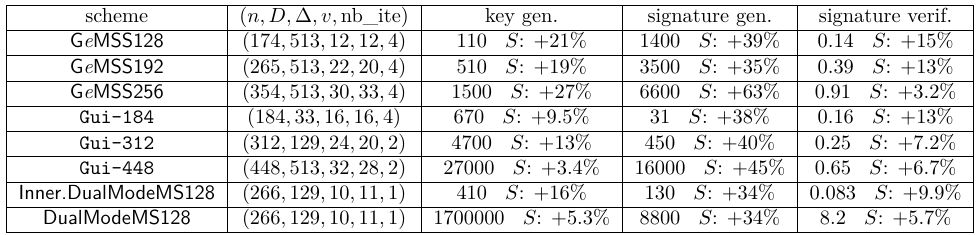
Table 17: Number of mega cycles (Mc) for each cryptographic operation with a Haswell processor (DesktopH), followed by the speed-up between Haswell and Skylake processors (DesktopH versus DesktopS). For example, 110 S : +21% means a performance of 110 Mc on Haswell, and a performance of 110 = 91 Mc on Skylake. 1 . 21